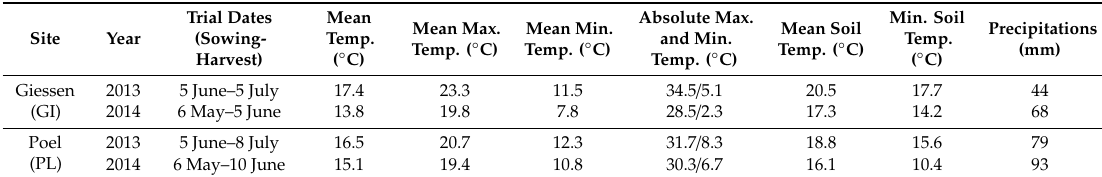
Table 1. Climate data of the field trial sites during the duration of the respective experiments for emergence and juvenile development.